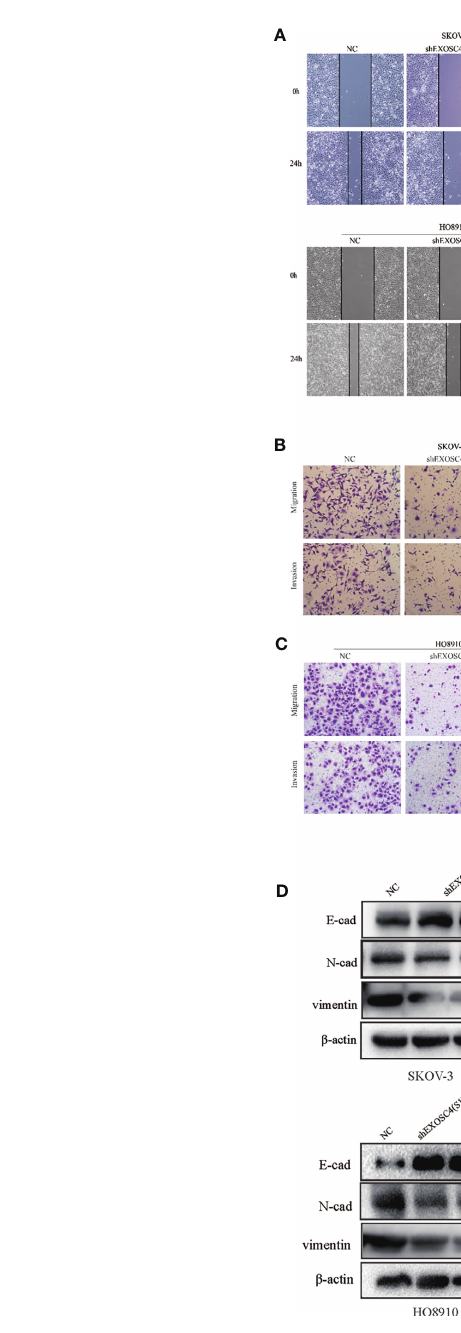
FIGURE 4 | EXOSC4 knockdown inhibits the migration and invasion of SKOV-3 and HO8910 cell lines. (A) Migration ability after EXOSC4 knockdown in SKOV-3 and HO8910 cells were assessed using the scratch assay (magni fi cation 100×), and migration rate was calculated. (B, C) Transwell assay to test invasion and migration ability. The number of invasion and migration SKOV-3 cells and HO8910 cells were counted; magni fi cation 200×. (D) Western-blot assays to determine the protein levels of E-cad, N-cad, and vimentin, and its band quanti fi cation. *p < 0.05, **p < 0.01, ***p <